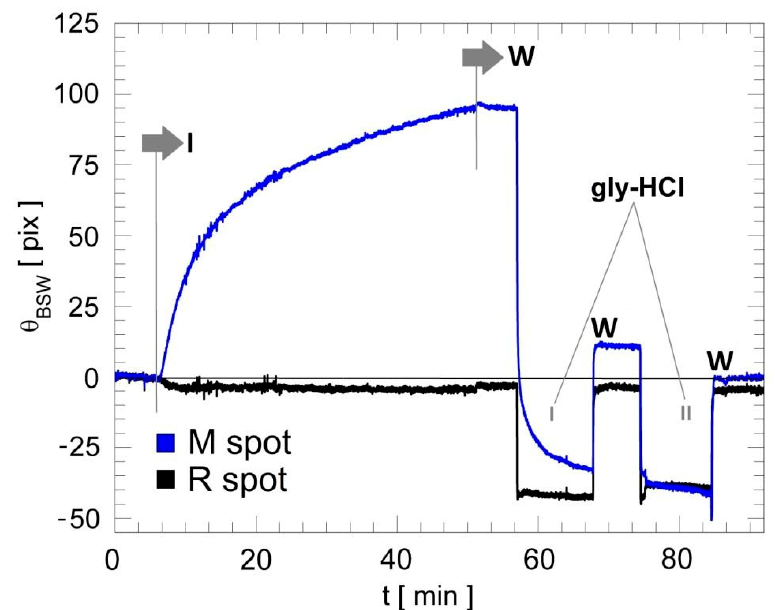
Figure 4. Sensograms of two spots in response to an Anti ‐ IgG injection and two regeneration steps in sequence. The two sensograms correspond to the reference spot with anti ‐ ovalbumin antibody (R, black curve) and the signal spot with human IgG antibody (M, blue curve). Then 10 min regeneration steps are performed to recover the starting conditions (before Anti ‐ IgG injection, I marker). W indicates the washing steps.